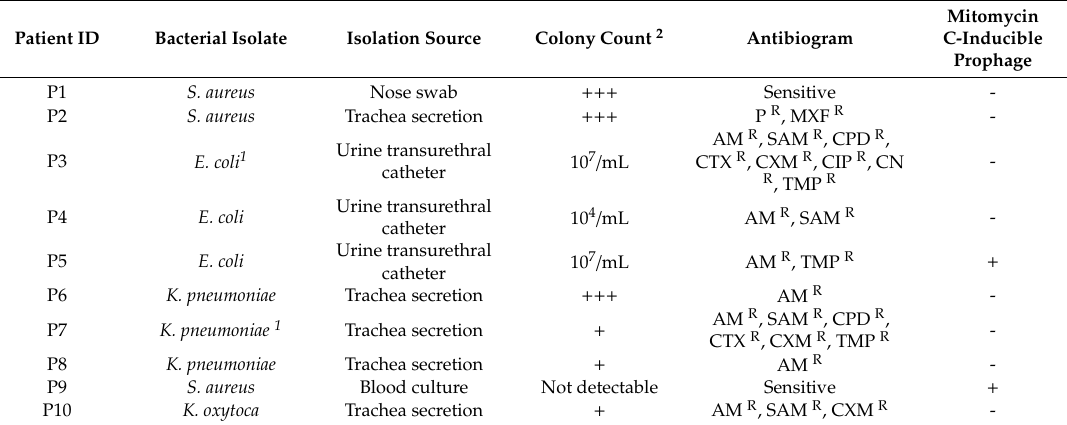
Table 2. Clinical isolate, isolation source, and corresponding